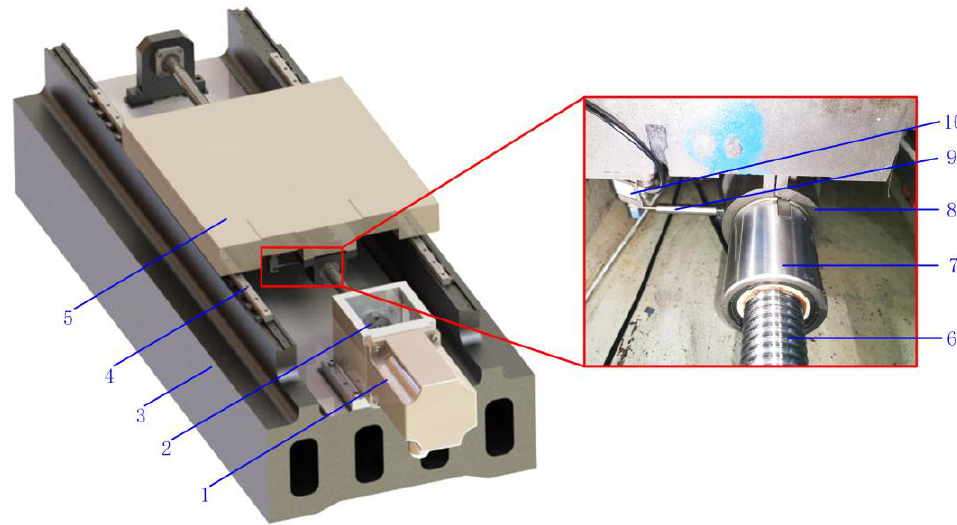
Figure 5. Experimental setup of the DNBSs. 1. Motor. 2. Coupling. 3. Base. 4. Guideway. 5. Table. 6. Screw. 7. Nut. 8. Clamping device. 9. Dowel bar. 10. Tension–compression sensor.